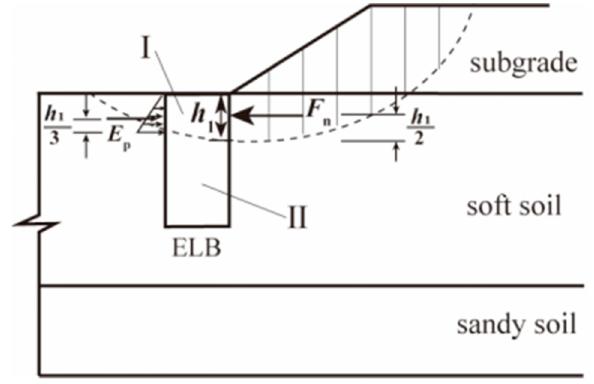
Figure 4. Shear failure diagram of the ELB.